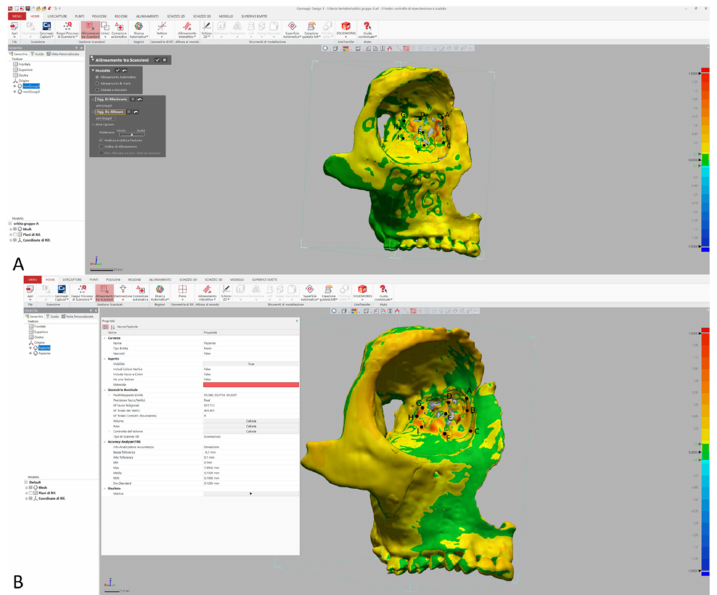
Figure 5. Color map distance between immediate post treatment orbit and 6-month follow-up orbit in Geomagic Design X software with the nine anatomical points considered. ( A ) Group A patient. ( B ) Group B patient.